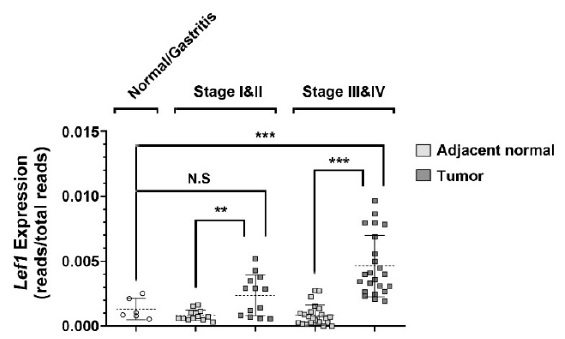
Figure 1. Lymphoid enhancer binding factor 1 ( Lef1 ) is overexpressed in gastric cancer. Scatter dot- plot shows the relative Lef1 expression in 6 normal/gastritis (open circle), 13 early gastric cancer (Stage I & II) and 23 advanced gastric cancer (Stage III & IV) specimens. Data presented as mean with error bars representing SD (** p < 0.01, *** p < 0.001).